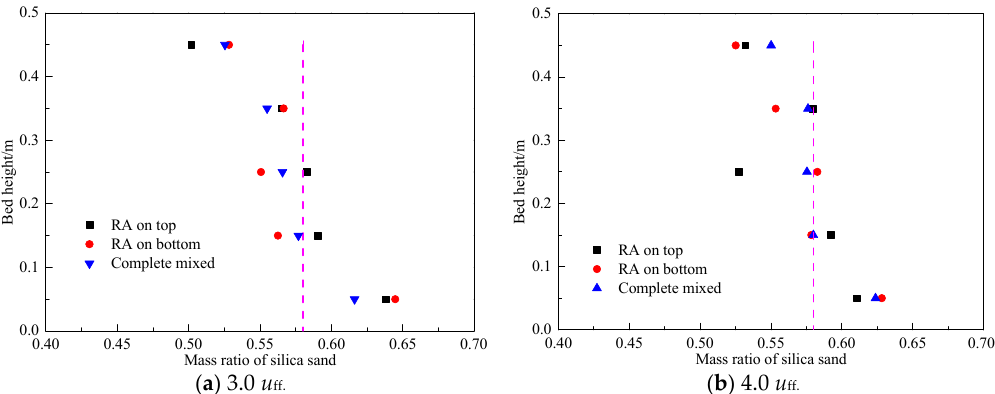
Figure 6. Effect of initial packing conditions on SS concentration distribution.